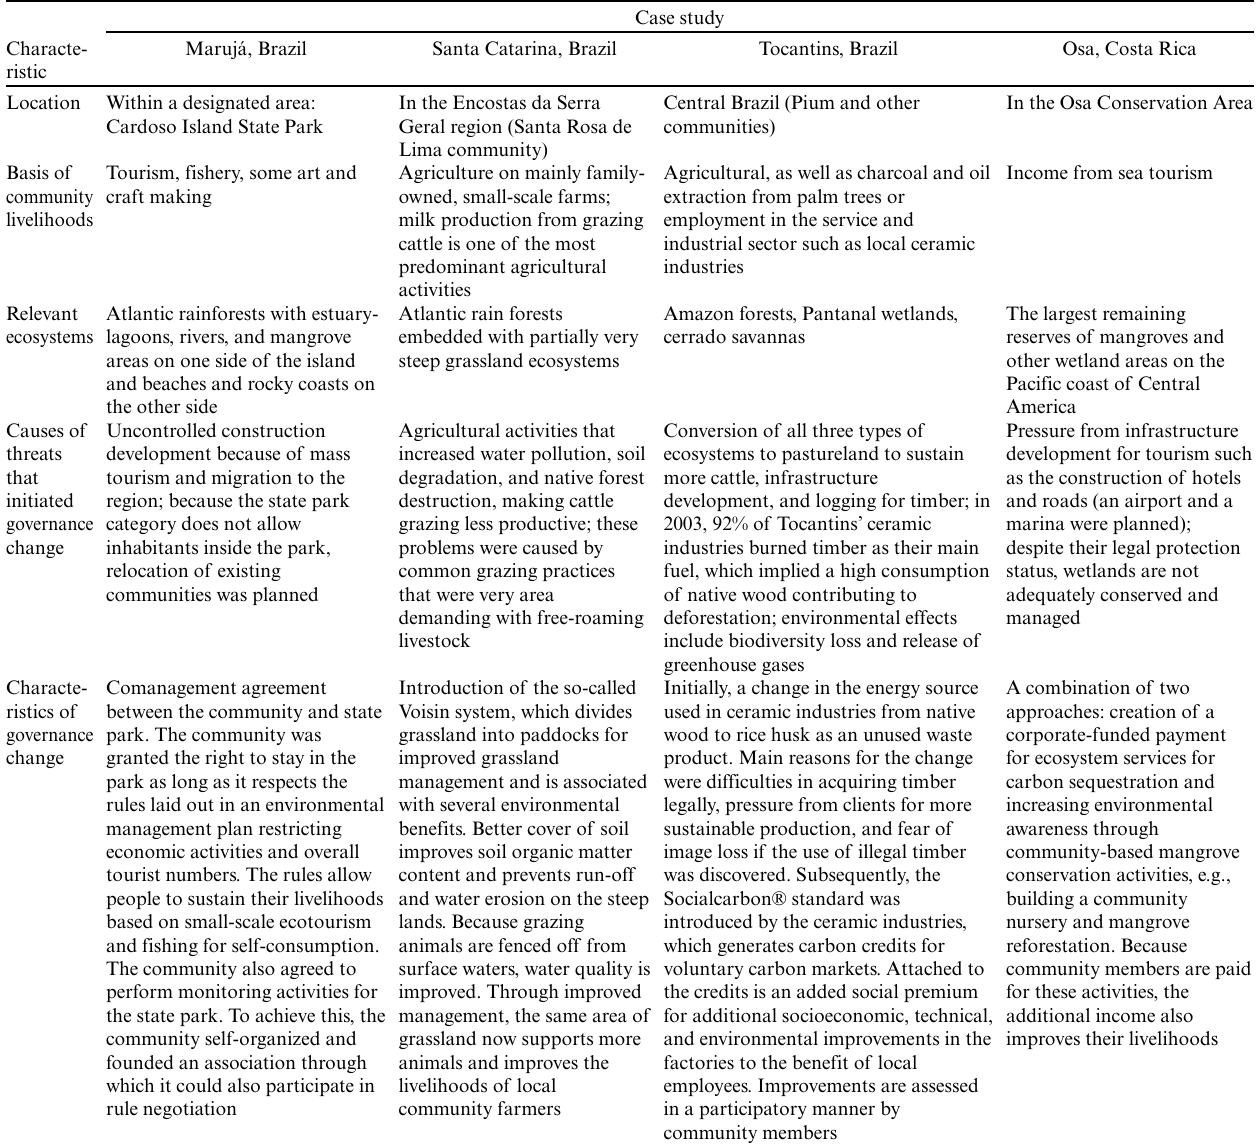
Table 1. Key characteristics of the selected case